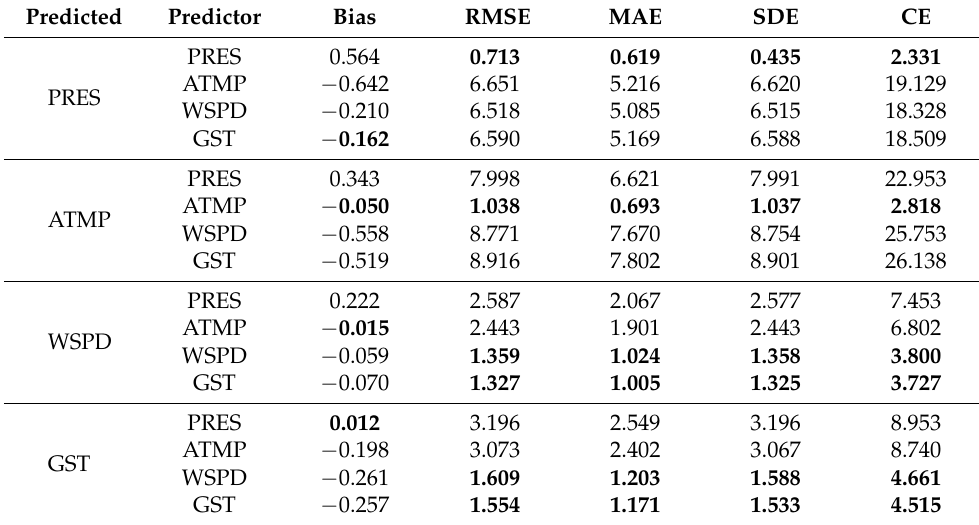
Table 6. Prediction errors for different variables used as